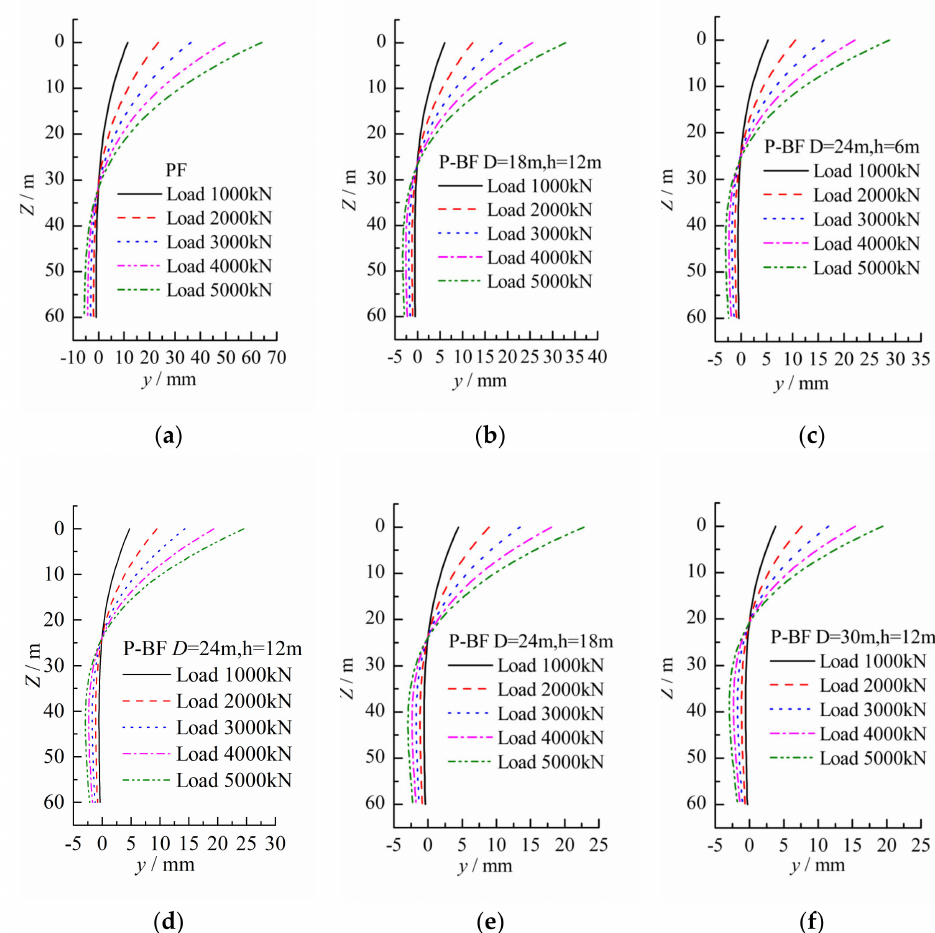
Figure 10. Lateral displacement of PF and P–BF. ( a ) Lateral displacement of PF. ( b ) Lateral displace- ment of P–BF. ( c ) Lateral displacement of P–BF; D /h = 18 m/12 m D / h = 24 m/6 m. ( d ) Lat- eral displacement of P–BF. ( e ) Lateral displacement of P–BF. ( f ) Lateral displacement of P–BF; D / h = 24 m/12 m D / h = 24 m/18 m D / h = 30 m/12